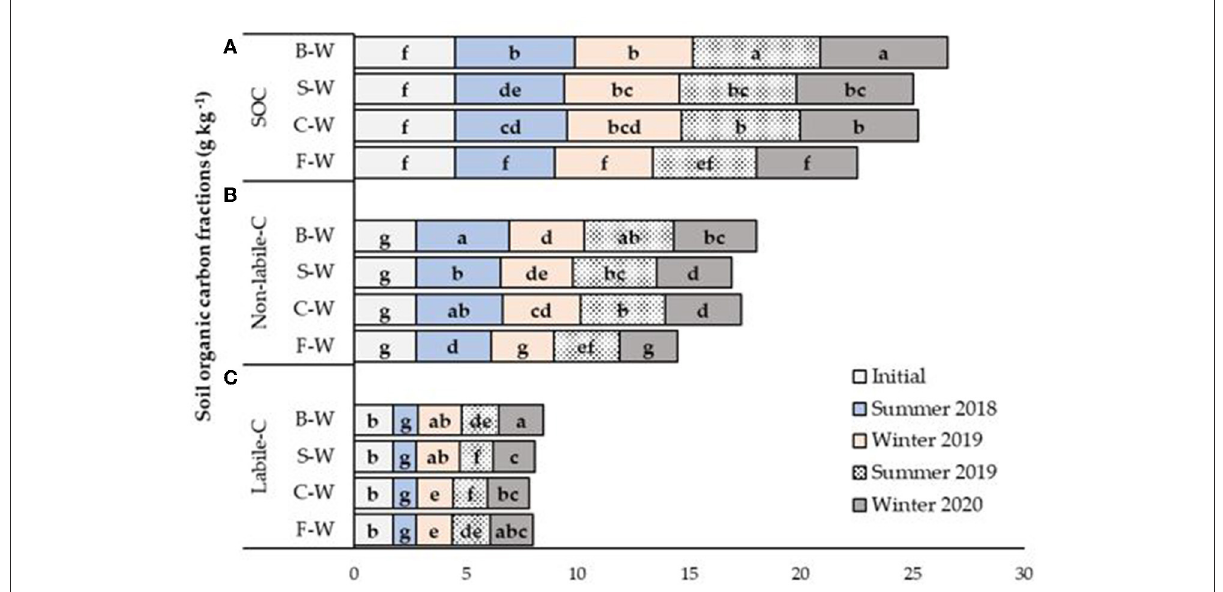
FIGURE3 Effects of four seasonal weather variations: summer 2018, 2019 and winter2019, 2020, and four crop rotation systems: F-W, fallow-wheat; C-W, corn-wheat; S-W, sesame-wheat, and B-W, mung bean-wheat on (A) soil organic carbon (SOC), (B) labile-C and (C) non-labile-C content. The initial bar indicates the measured values at the start of the experiment. Letters indicate significant difference at p ≤ 0.05 according to Duncan’s multiple range test. Identical letters indicate no significant difference between the